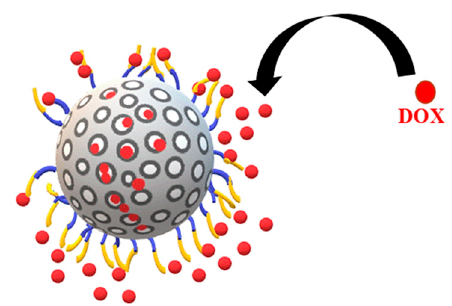
Figure 4. Representation of polyethylene glycol and chitosan-coated MSN loaded with DOX. Table 3. Loading Capacity of PCMSNs with DOX. Doxorubicin Loaded MSNS